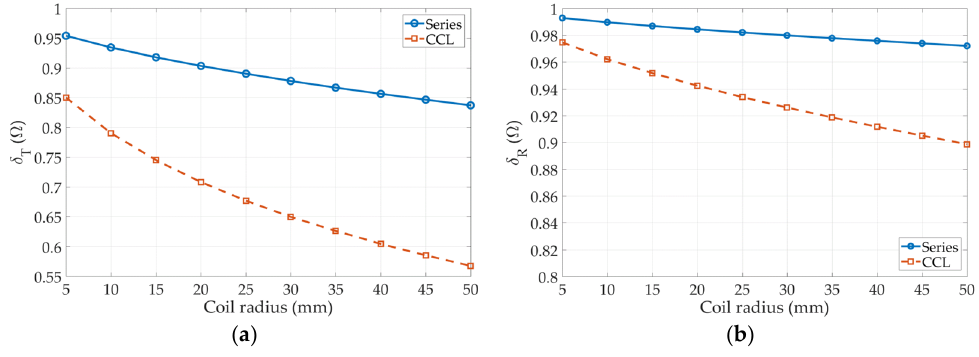
Figure 15. ( a ) Transmitter efficiency and ( b ) receiver efficiency.